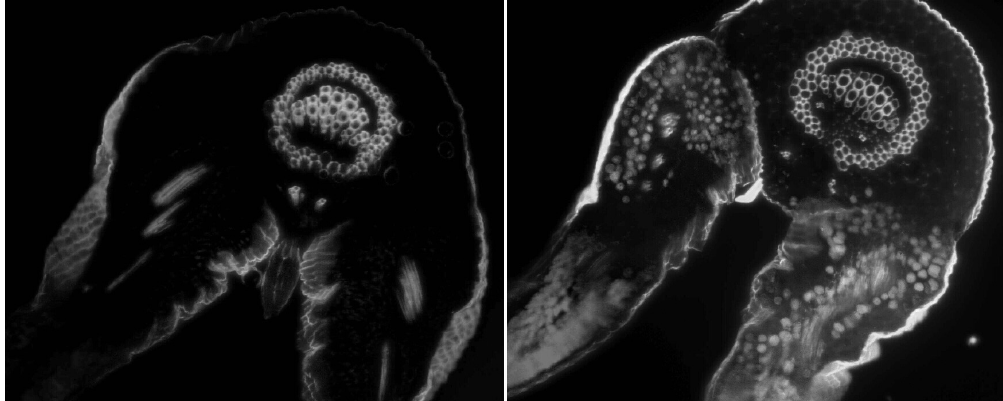
Figure 3. Binding experiment using a fluorescentprobe